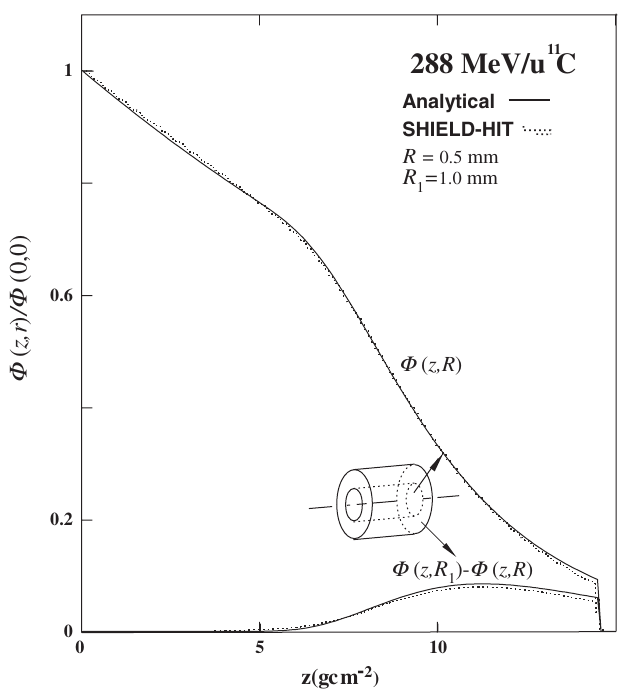
FIG. 2. The depth variation of the analytical narrow depth fluence (solid lines) (cid:3) ð z; R Þ and (cid:3) ð z; R 1 Þ [Eq. (27)], and the MC calculated fluences (dotted histograms) for the primary 11 C (cid:8) þ emitter. The shape of the pencil beam depth fluence curve coincides with shape of the broad beam depth fluence, up to the range of 5 cm owing to the low mass-scattering power value at high energies of the projectile. The close agreement between the analytical calculation and the MC data confirms the present pencil beam solution of the Boltzmann equation for the primary ions.